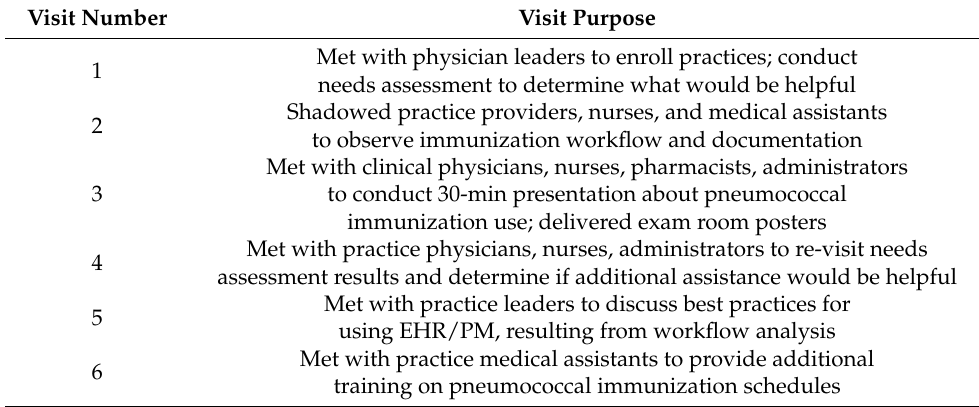
Table 1. Schedule of academic detailing